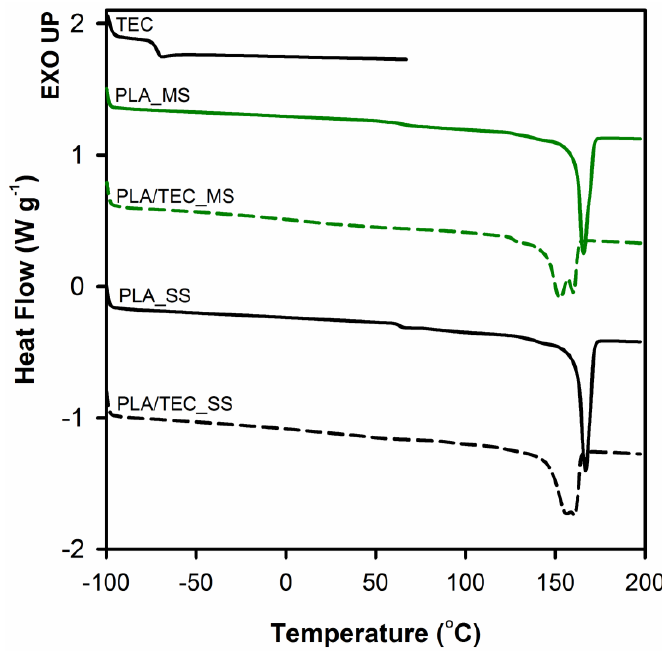
Figure 5. Di ff erential scanning calorimetry (DSC) thermograms of polylactide and polylactide / triethyl citrate systems. Thermograms have been shifted along the vertical axis for better